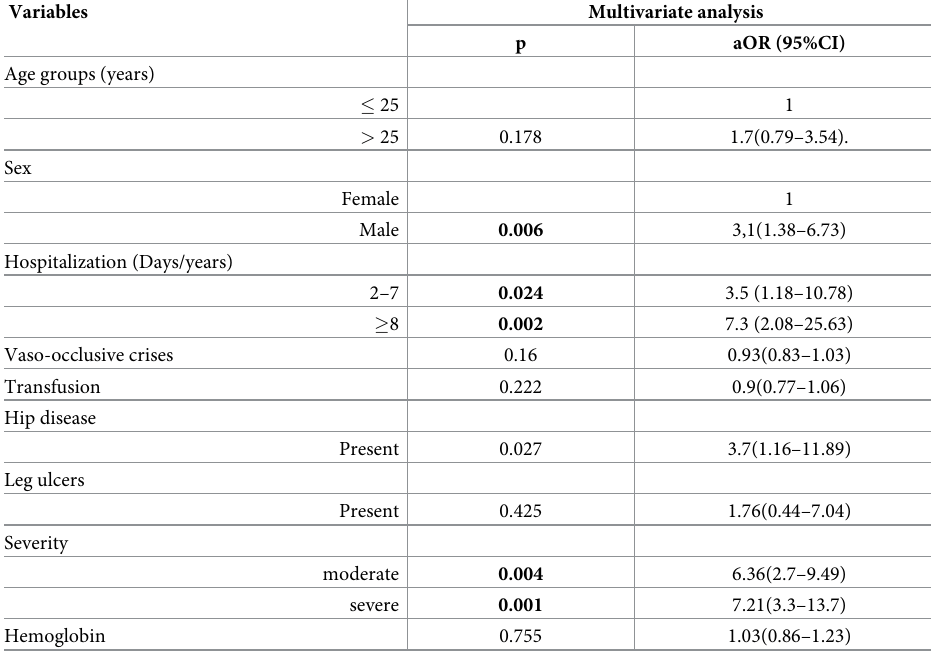
Table 3. Factors associated with malnutrition (BMI < 18.5 kg/m 2